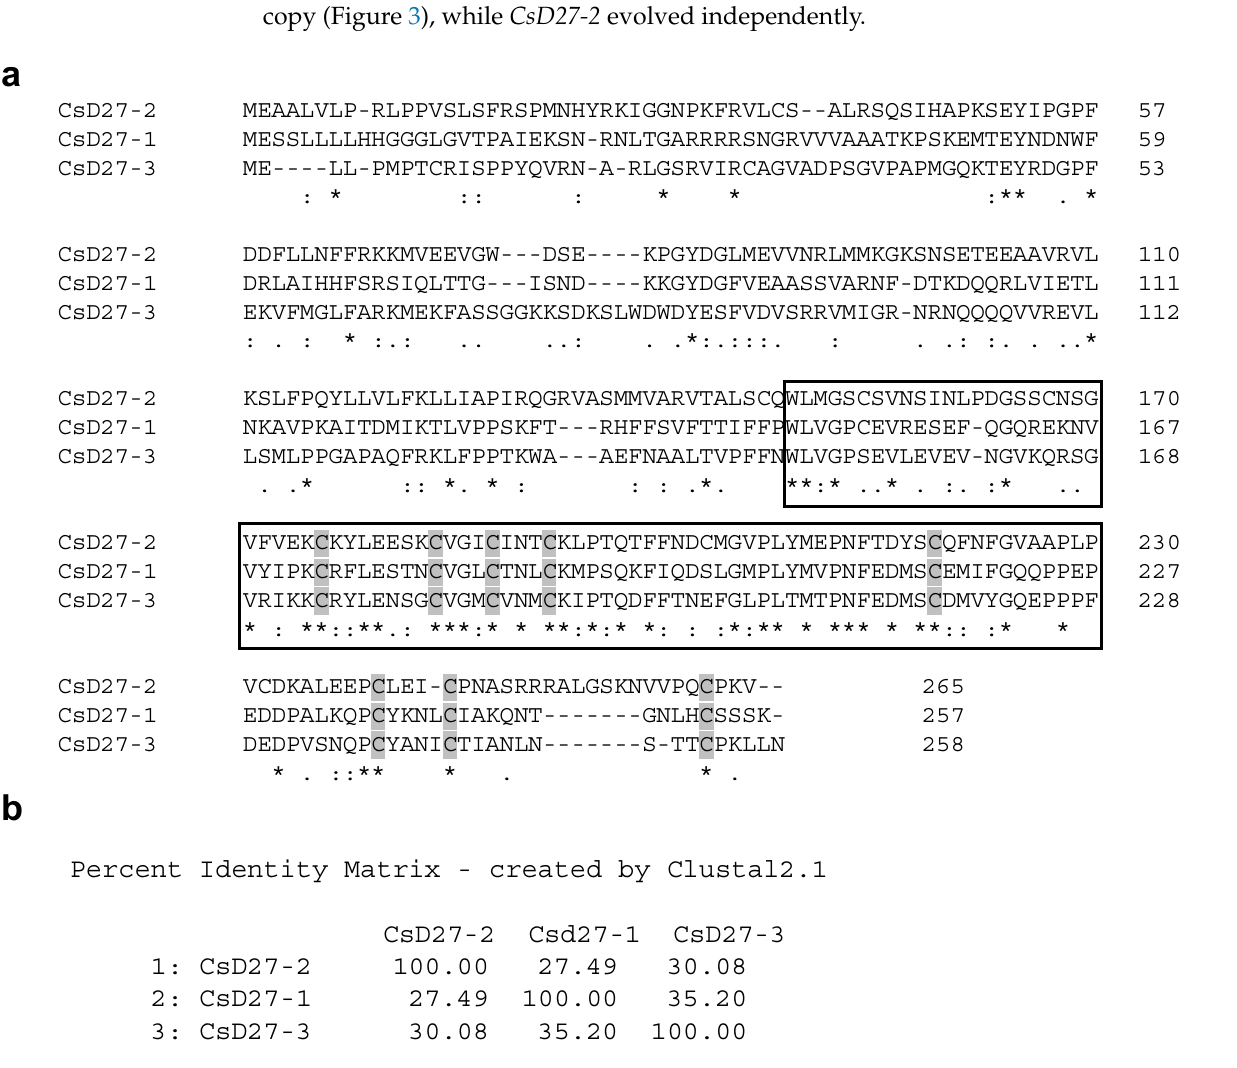
Figure 2. Sequence characteristics of CsD27 enzymes. ( a ) Amino acid sequence alignments among CsD27 enzymes. The amino acid sequence alignments were made by CLUSTAL omega. Conserved cysteines (C) are highlighted in grey, to indicate structural conservation. Amino acids that constitute the conserved domain of D27 isomerase in higher plants are framed in black. Asterisks denote fully conserved residues, while colons and dots denote partially conserved residues. ( b ) Percent identity matrix among the CsD27 amino acid sequences.